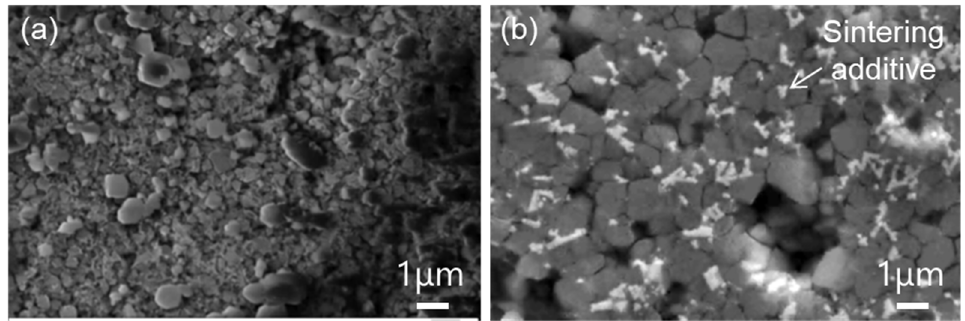
Figure 8. SEM images of the LPS SiC ( a ) and the modified LPS ( b ) surfaces following high-temperature water corrosion (2 ppm dissolved oxygen, 20 MPa, 320 °C, and 168 h).